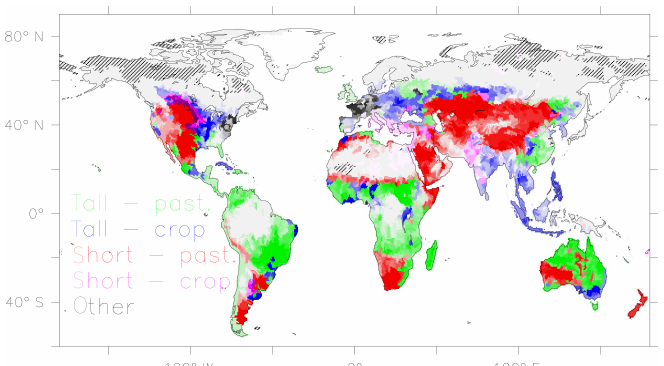
Figure A5. Areas covered by selected subbasins (3995 in total, see Table 2 and Sect. 3.1). Green areas indicate where the main change in the subbasin is from tall natural to pasture, blue represents tall natural to crops, red represents short natural to pasture and purple represents short natural to crops. Gray indicates subbasins where the main change is from crops or pasture to tall or short natural (e.g., in western Europe, eastern North America). Dashed black indicates where there is no land cover change (e.g., high polar latitudes). Color intensity indicates the change in natural vegetation, with near-white indicating almost no change and most saturated colors indicating that tall or short natural vegetation has decreased or increased at least 50%. Table 2 shows the surface areas in each of these